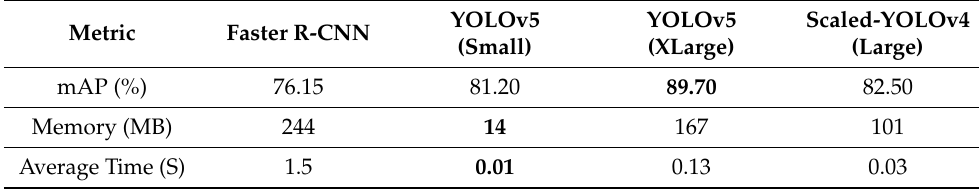
Table 1. Computer Vision models performance.